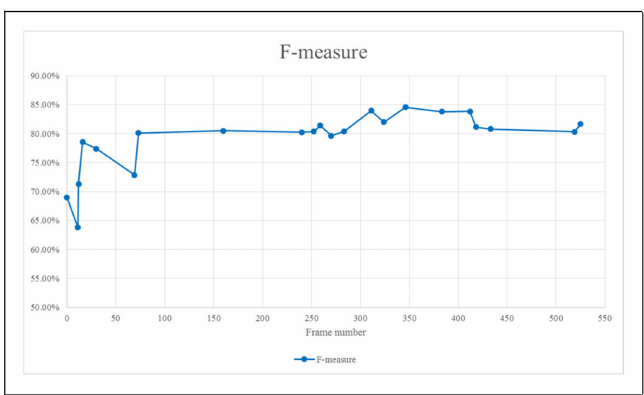
Figure 28. F-measure learning